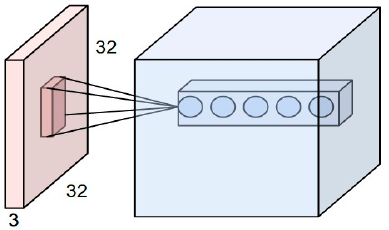
Figure 4. Convolving a small region of an image with a set of 5 filters of size F × F. Nonlinearity (ReLu)